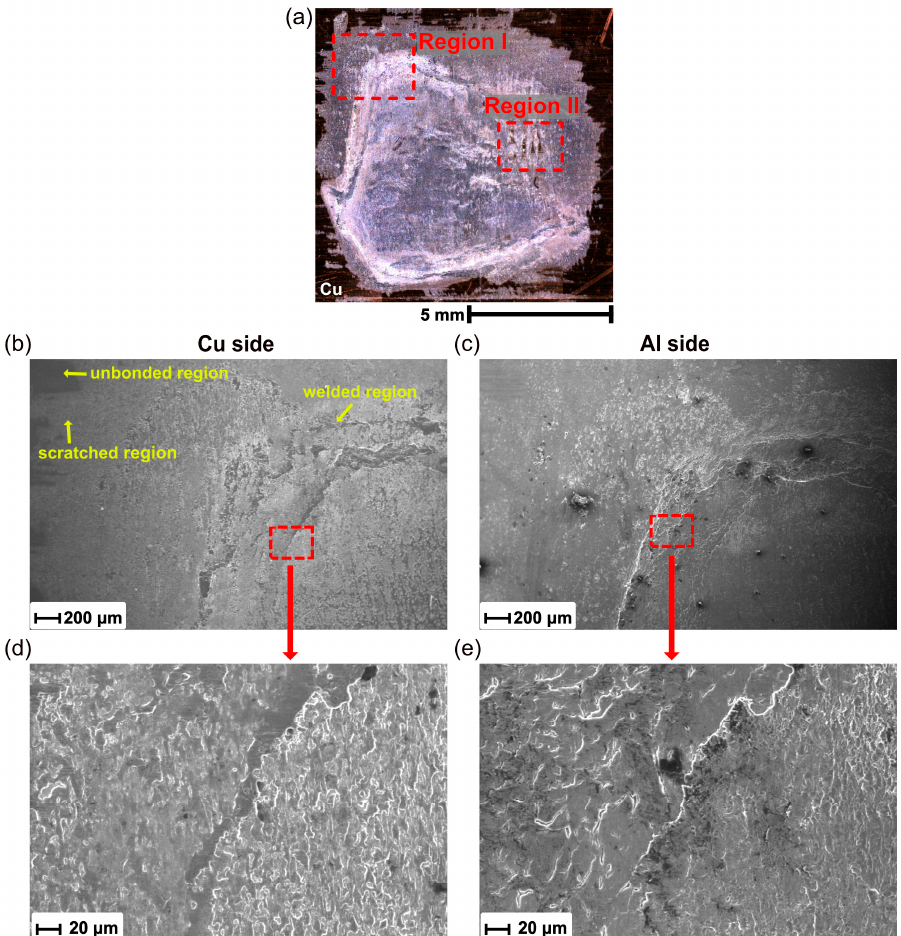
Figure 13. ( a ) Optical micrograph of fracture surface of Al/Cu joint, ( b , c ) SEM images of the fracture morphology for the Al/Cu joint in Region I, and ( d , e ) magni fi ed view of selected region.